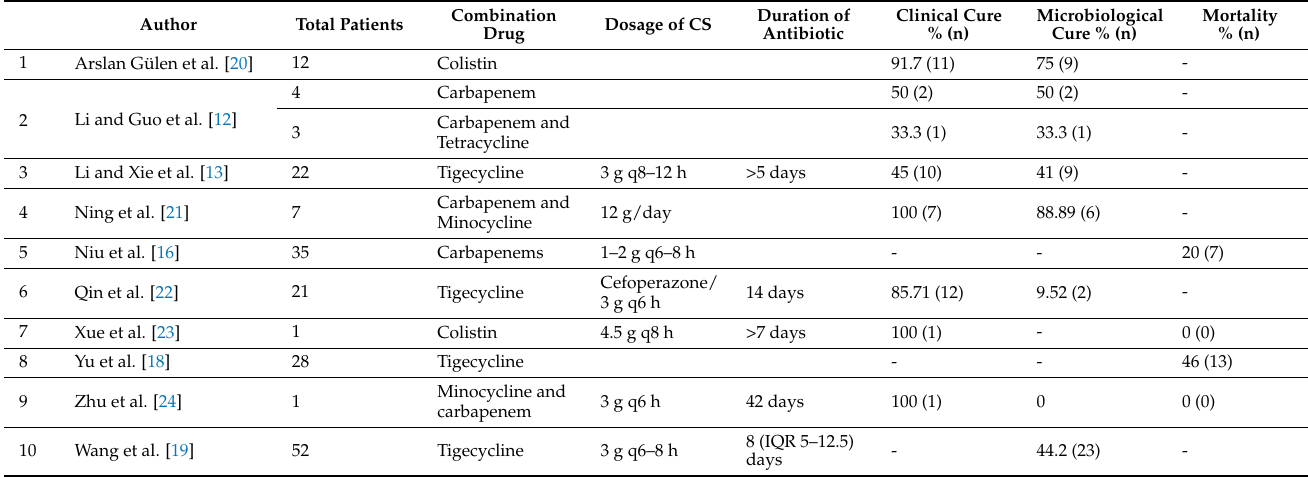
Table 6. Outcome of patients treated with cefoperazone-sulbactam in combination with colistin or polymyxin, tigecycline, and